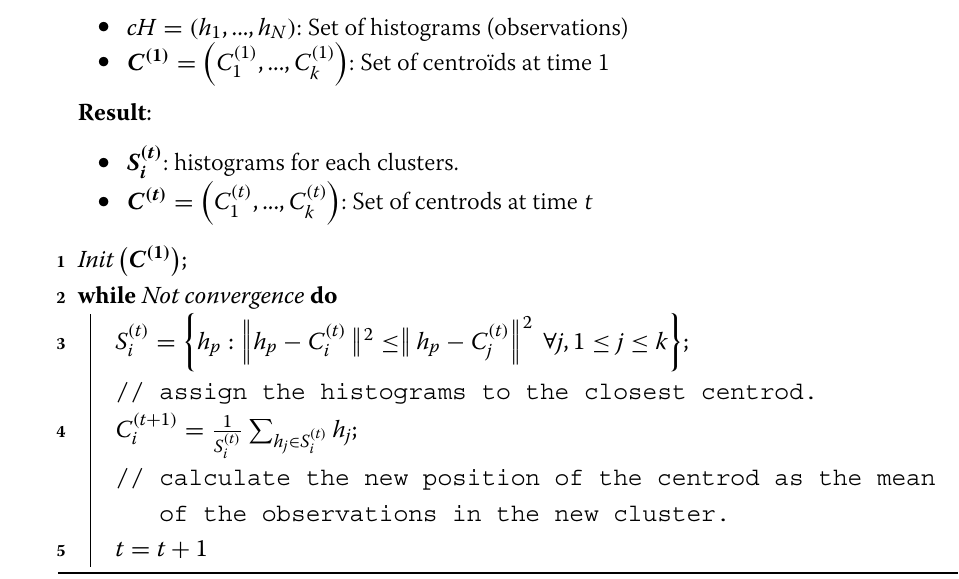
Algorithm 2: Histograms clustering using